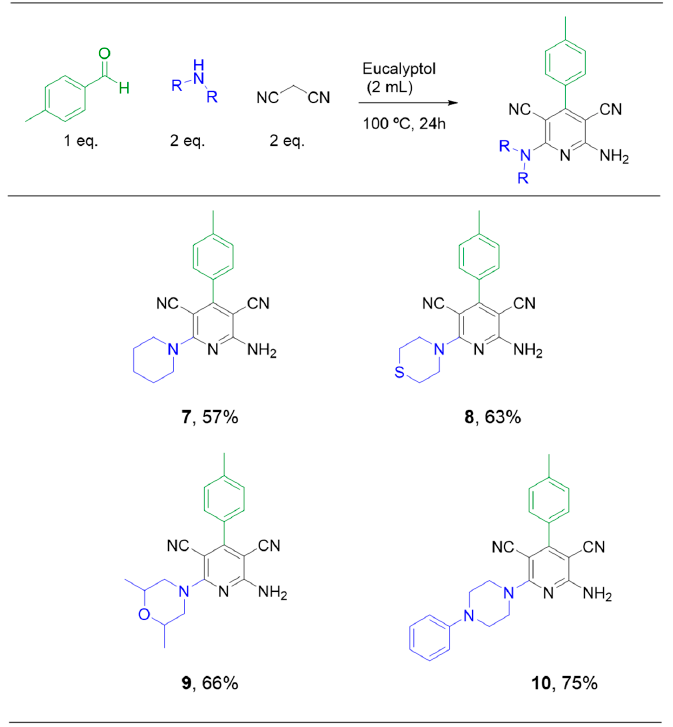
Figure 4. Multicomponent reaction for the synthesis of highly functionalized pyridines.